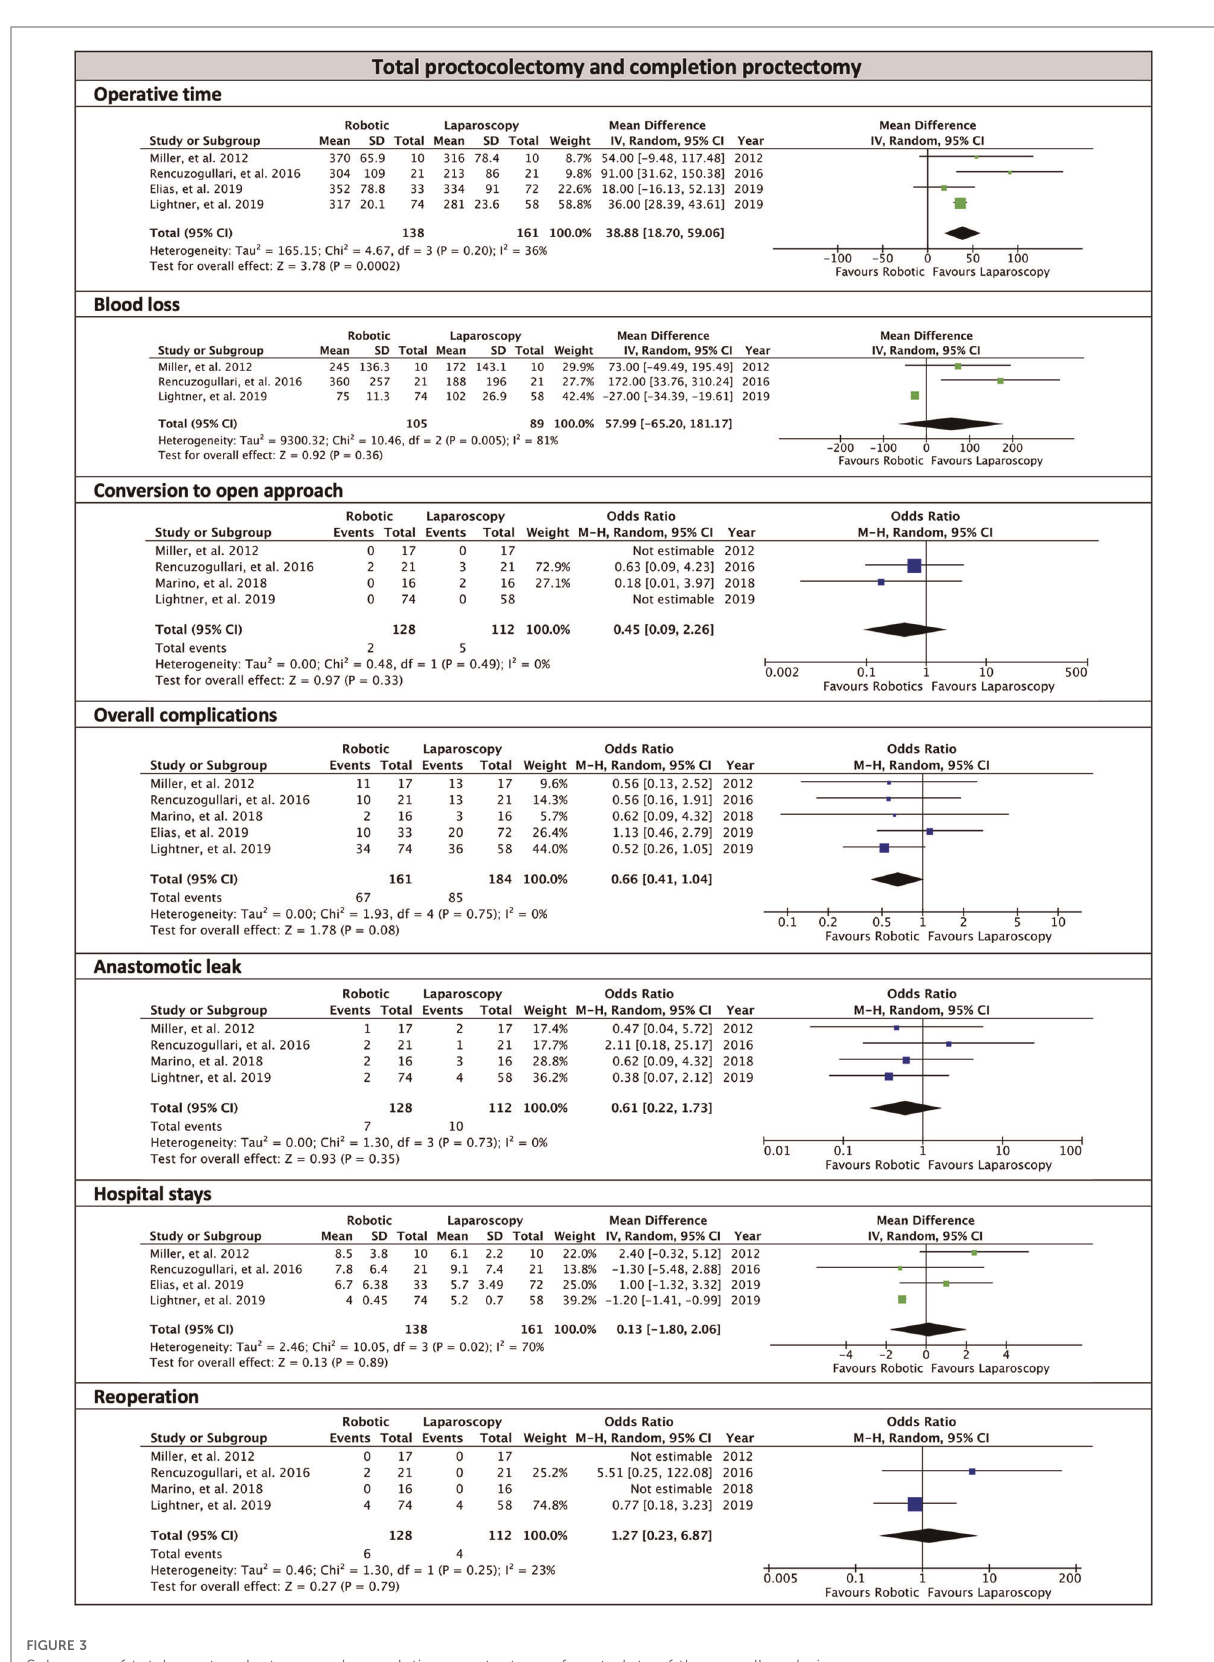
FIGURE 3 Subgroup of total proctocolectomy and completion proctectomy, forest plots of the overall analysis.